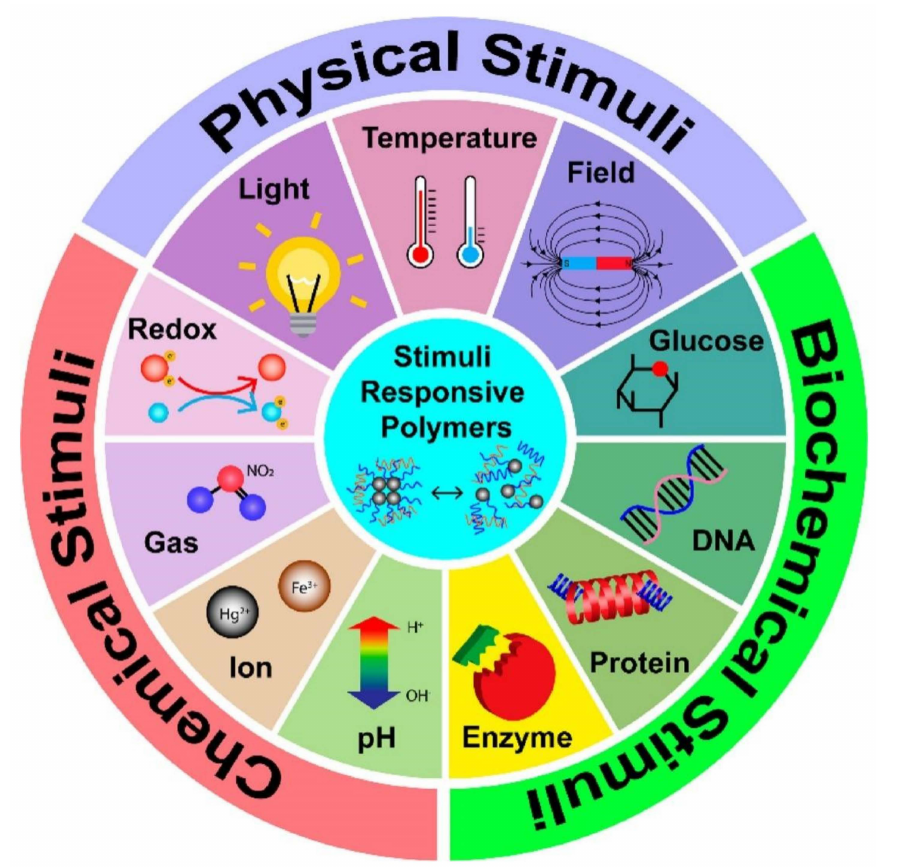
Figure 6. Physical, chemical, and biochemical responsiveness of stimuli-responsive polymers [51]. Copyright 2021, American Chemical